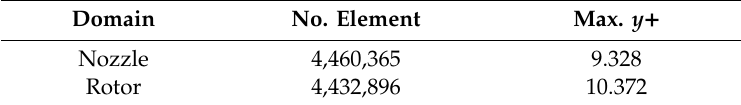
Figure 9. Convergence test results of the final geometry. Table 5. Information of final